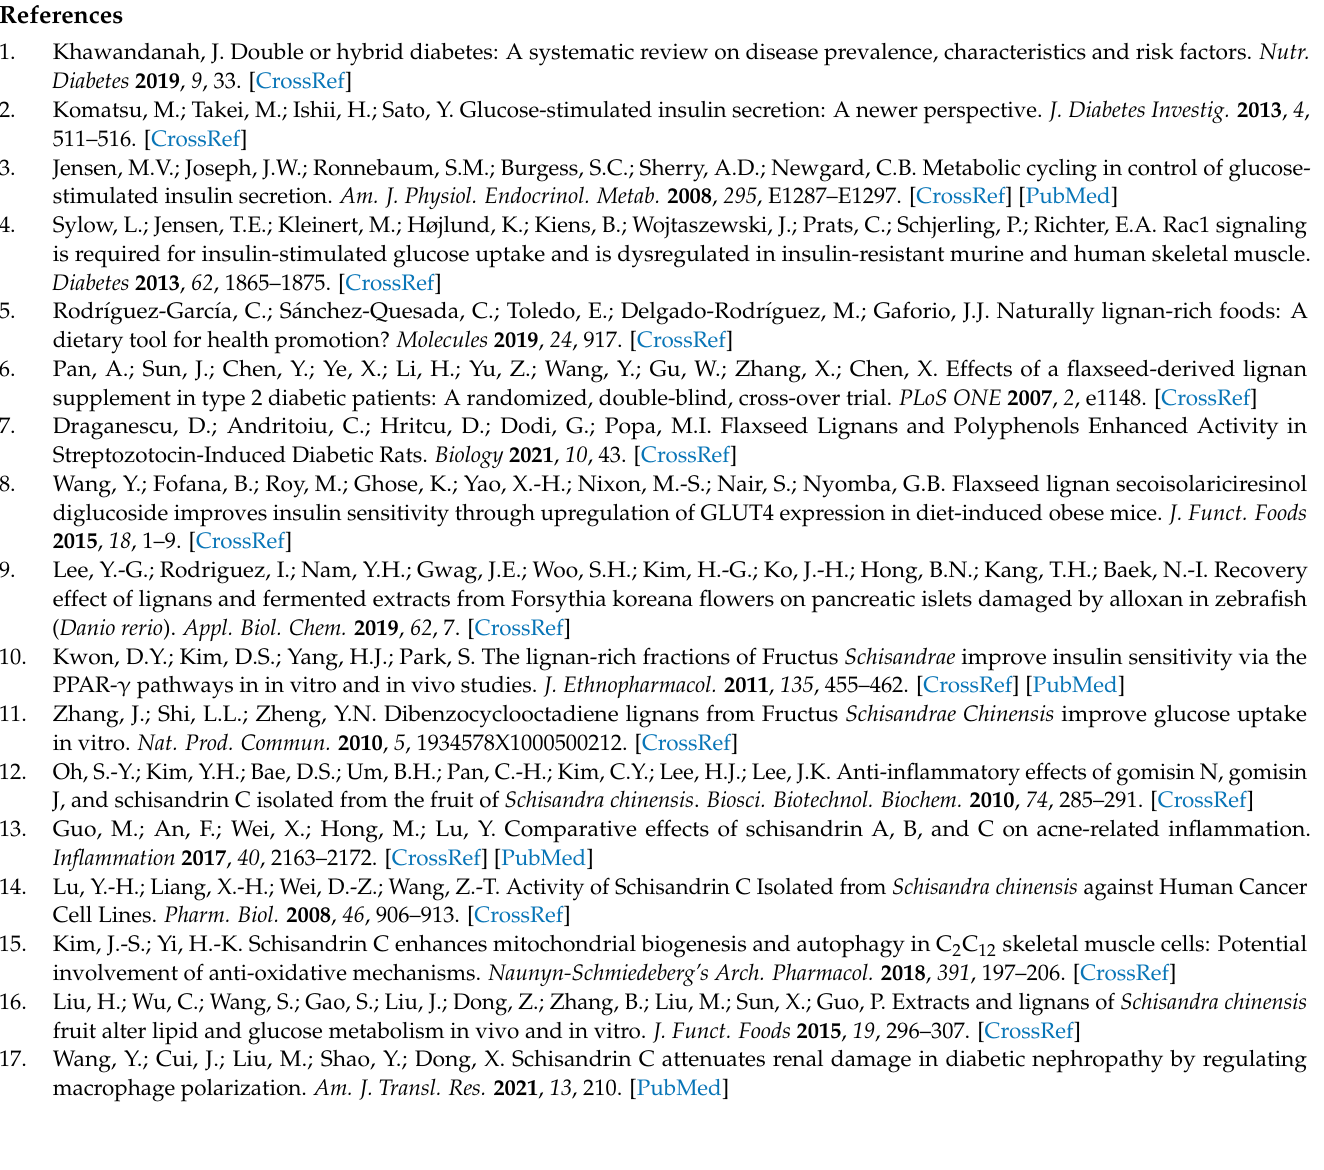
Supplementary Materials: Figure S1: Effect of schisandrin C on the protein expression levels of peroxisome proliferator-activated receptor γ (PPAR γ ), pancreatic and duodenal homeobox 1 (PDX- 1), phospho-insulin receptor substrate-2 (P-IRS-2) (Ser731), IRS-2, phospho-phosphatidylinositol 3-kinase (P-PI3K), PI3K, phospho-Akt (P-Akt) (Ser473), and Akt, Figure S2: Effects of schisandrin C on the glucose uptake in C2C12 cells. (C) Effect of schisandrin C on the protein expression levels of phospho-insulin receptor substrate-1 (P-IRS-1), IRS-1, phospho-AMP-activated protein kinase (P-AMPK), AMPK, phospho-phosphatidylinositol 3-kinase (P-PI3K), PI3K, phospho-Akt (P-Akt) (Ser473), Akt, glucose transporter type 4 (GLUT-4), and glyceraldehyde 3-phosphate dehydrogenase (GAPDH) in INS-1 cells treated or untreated with 2.5 and 5 µ M schisandrin C for 24